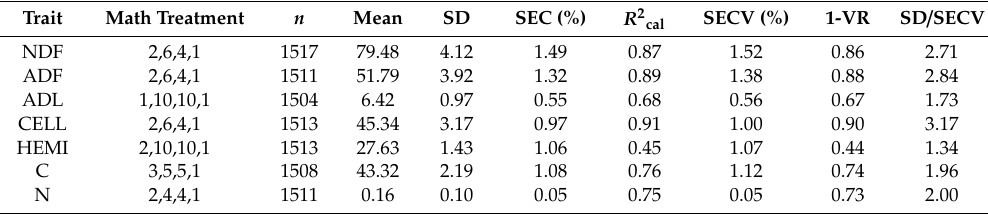
Table 1. Near-infrared spectroscopy (NIRS) calibration statistics of the broad models developed when combining a population of 480 cultivars in four environments.